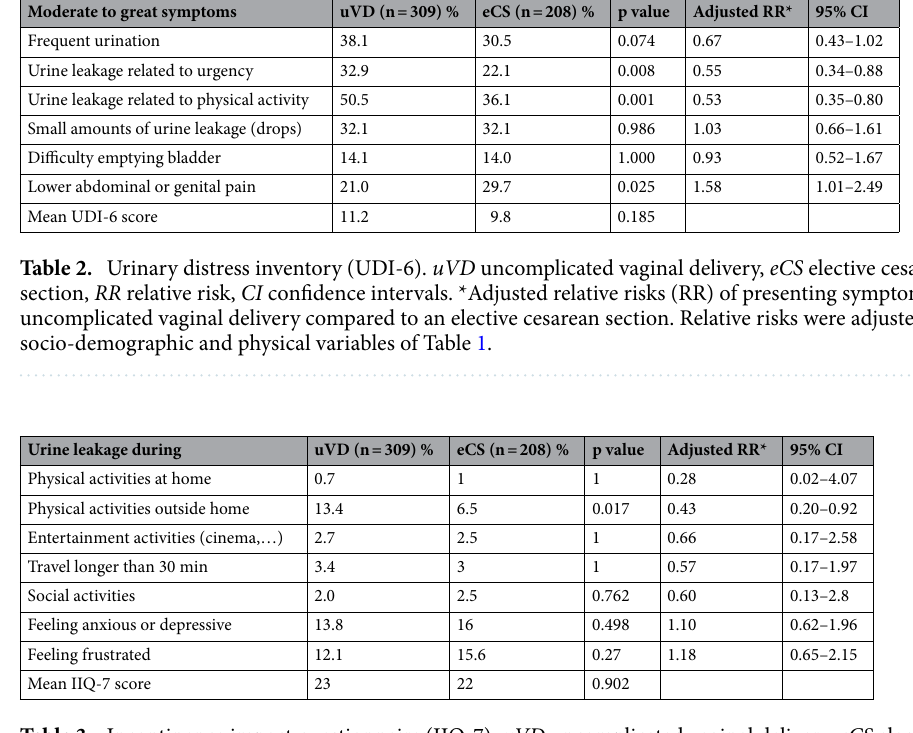
Table 3. Incontinence impact questionnaire (IIQ-7). uVD uncomplicated vaginal delivery, eCS elective cesarean section, RR relative risk, CI confidence intervals. *Adjusted relative risks (RR) of presenting symptoms after a uncomplicated vaginal delivery compared to an elective cesarean section. Relative risks were adjusted for all socio-demographic and physical variables of Table 1.